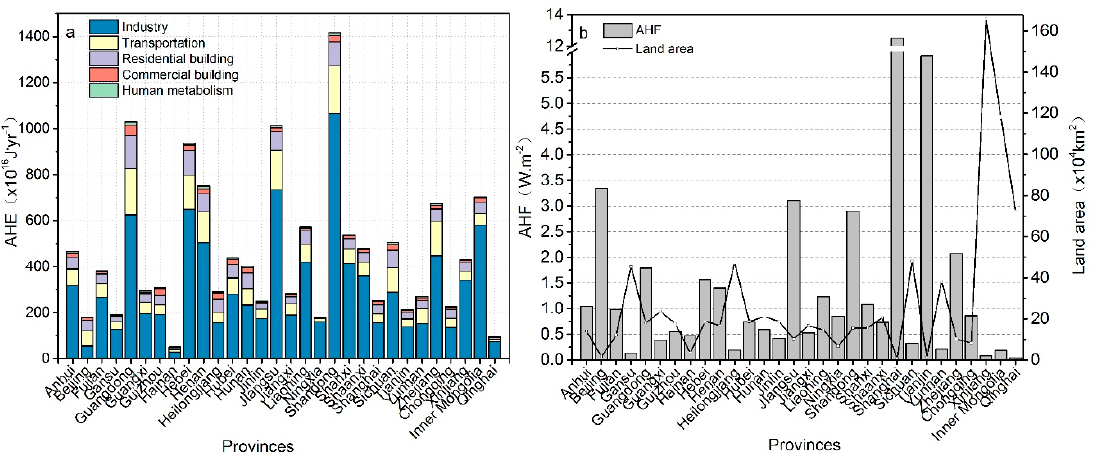
Figure 3. The anthropogenic heat emission (AHE) and AHF results in 2016. ( a ) AHE of different heat sources in provinces. ( b ) AHF of the provinces.